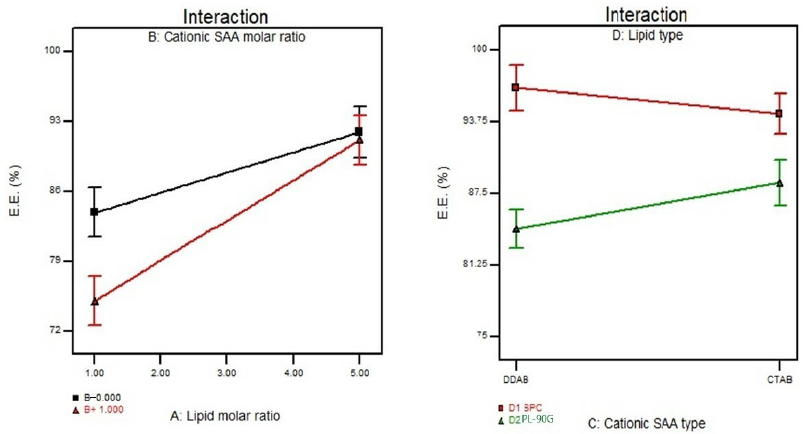
Figure 1. The effect of lipid molar ratio (X 1 ), cationic surfactant molar ratio (X 2 ), cationic surfactant type (X 3 ), and lipid type (X 4 ) on E.E.%. Abbreviation: E.E.%, entrapment efficiency percent.